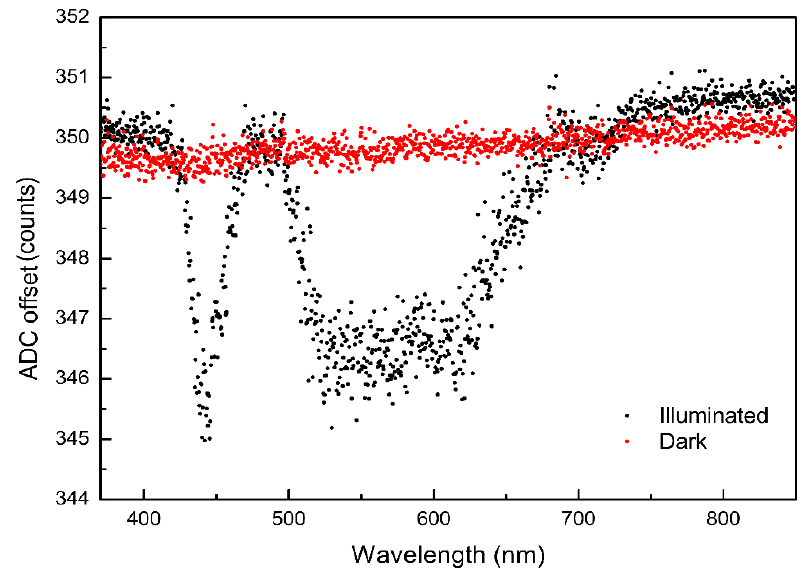
Figure 8. ADC offset in counts for all pixels of the CCD line. The black dots were for an enabled light source (illuminated) and the red dots were determined for a disabled light source (dark).